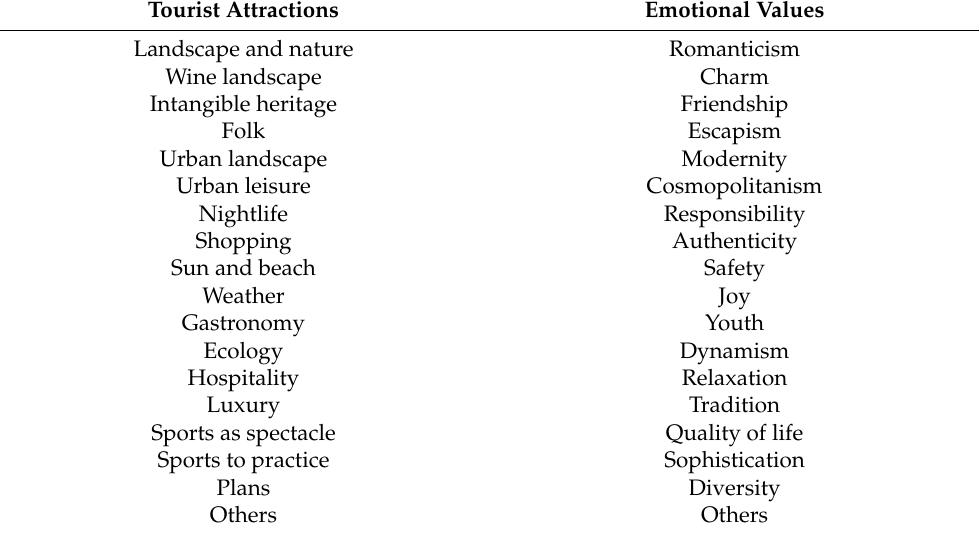
Table 1. Content analysis sheet.